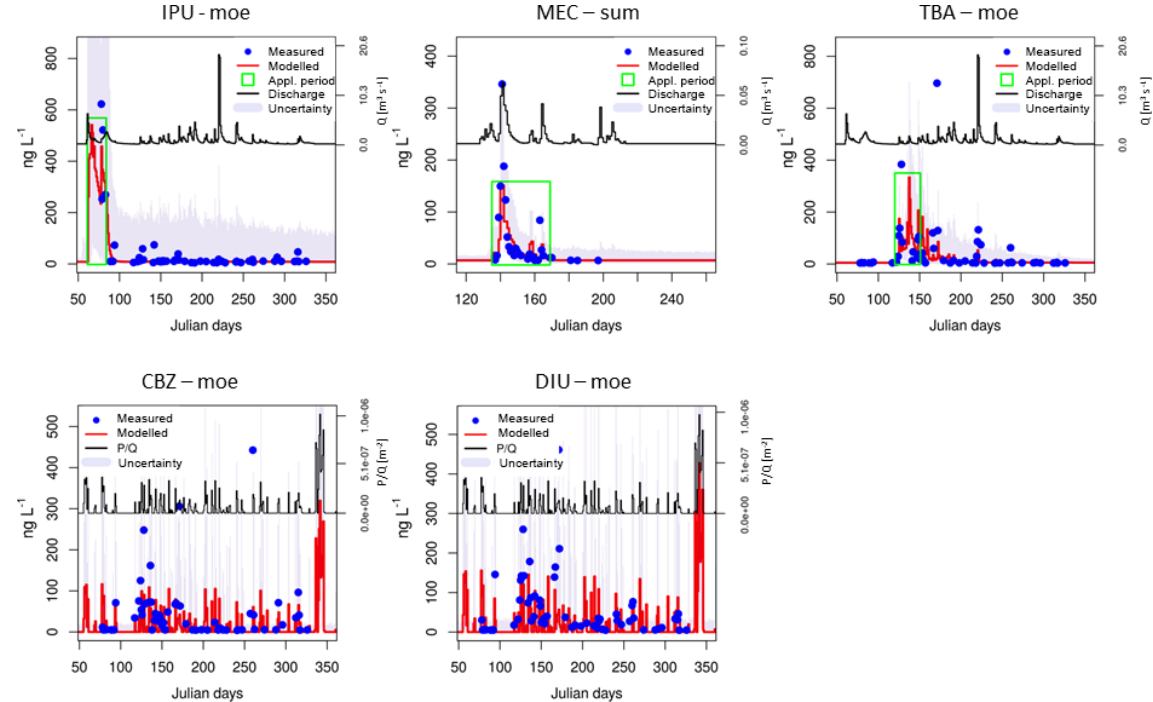
Figure 3. Examples of the comparison between simulated and observed concentration time series during the calibration step for each com- pound. IPU: isoproturon, MEC: S-metolachlor, TBA: terbuthylazine, CBZ: carbendazim, DIU: diuron. Moe: Mönchaltdorf, sum: Summerau. The full set of calibrations is shown in the Supplement (Fig.